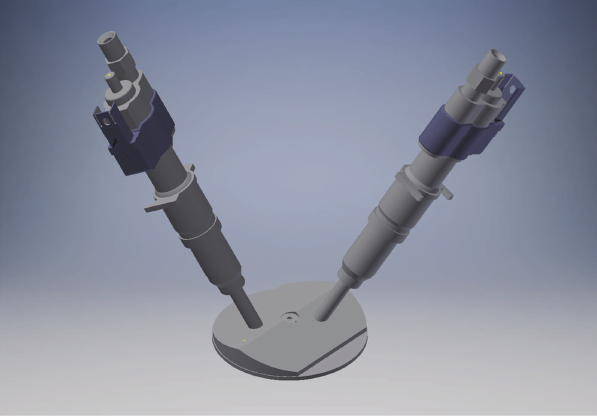
Fig. 4. The indicative view of positioning the direct injection fuel injectors